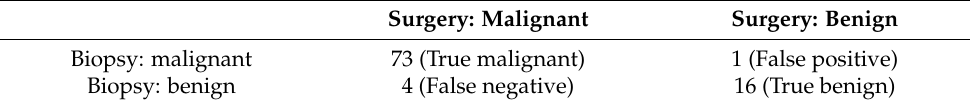
Table 4. Comparative analysis of tru-cut biopsy and surgically obtained histological results. Surgery: Malignant Surgery: Benign